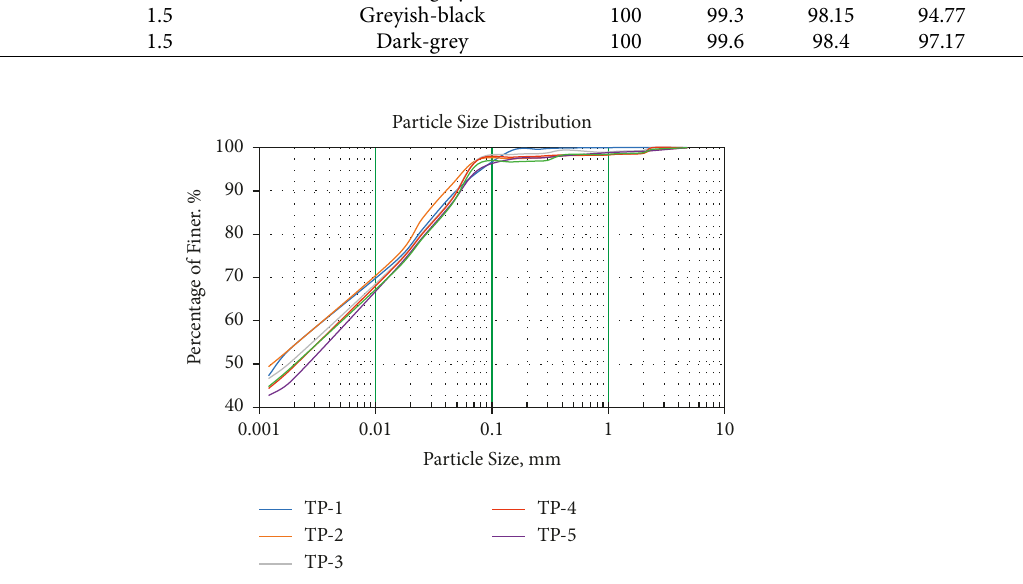
Figure 3: Particle size distribution curve. Table 3: Soil expansiveness based on